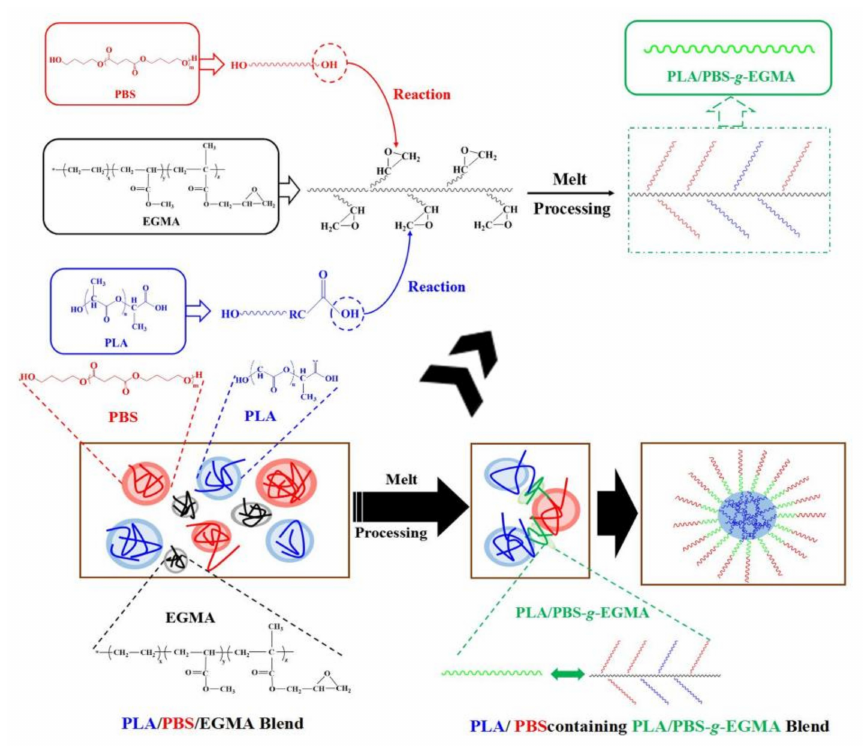
Figure 2. Schematic diagram of possible reaction routes in PLA/PBS blend with the inclusion of